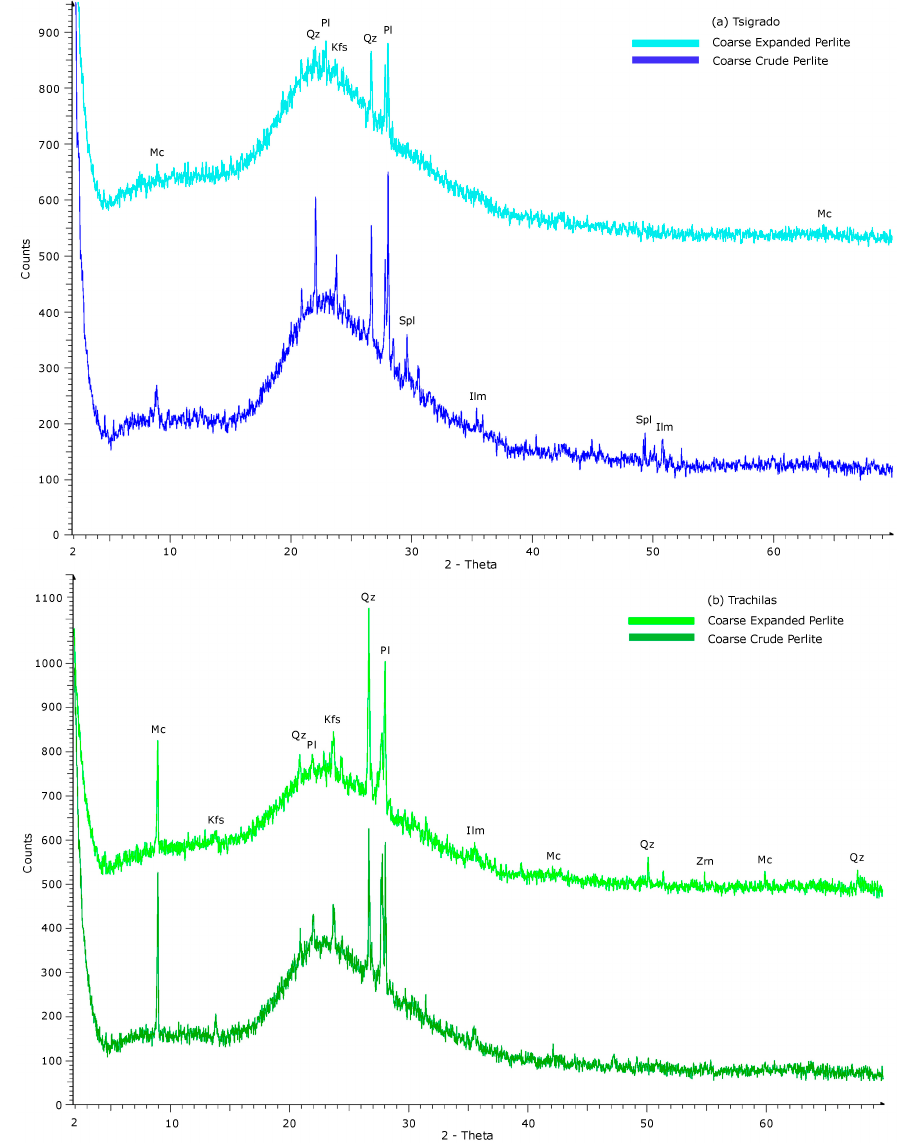
Figure 1. XRD patterns of two 1.18–2.5 mm crude perlite samples from Milos Island and their expanded counterparts: ( a ) Tsigrado area (sample TS1) and ( b ) Trachilas area (sample TR1). For clarity, patterns of the expanded samples have been shifted 400 counts along the y -axis. Qz: quartz; Pl: plagioclase; Kfs: K-feldspar; Mc: mica; Phg: phengite; Spl: spinel; Ilm: ilmenite; Zrn: